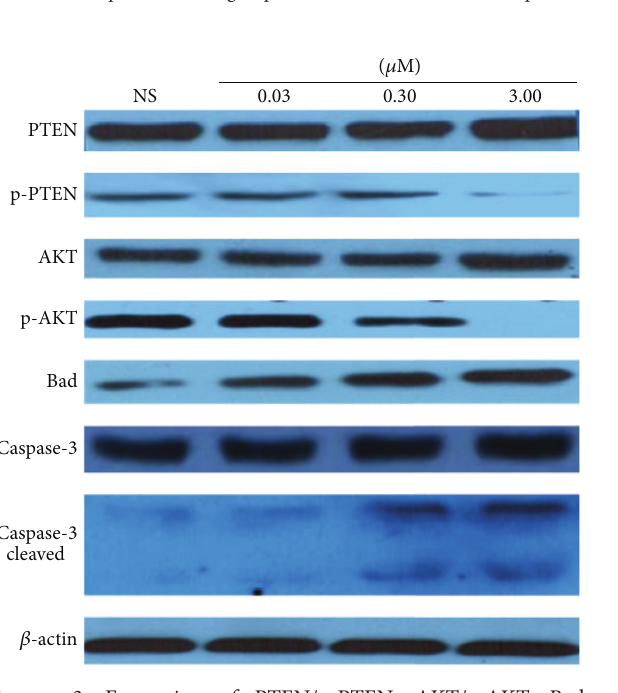
Figure 3: Expression of PTEN/p-PTEN, AKT/p-AKT, Bad, Caspase-3/Caspase-3 cleaved in control, and Bufalin-treated cells. The expression of PTEN was upregulated in cells treated with 3 𝜇 M Bufalin, while the p-PTEN were significantly decreased in cells treated with 0.3 𝜇 M and 3 𝜇 M Bufalin compared to the control group ( 𝑃 < 0.05 ). There was significant downregulation of p-AKT in cells treated with 0.3 𝜇 M and 3 𝜇 M Bufalin ( 𝑃 < 0.05 ). The Bad expression was increased ( 𝑃 < 0.05 ) in Bufalin-treated cells. The treatment of 0.3 𝜇 M and 3 𝜇 M Bufalin caused cleaves of Caspase-3 (fragments with molecular weight of 17 or